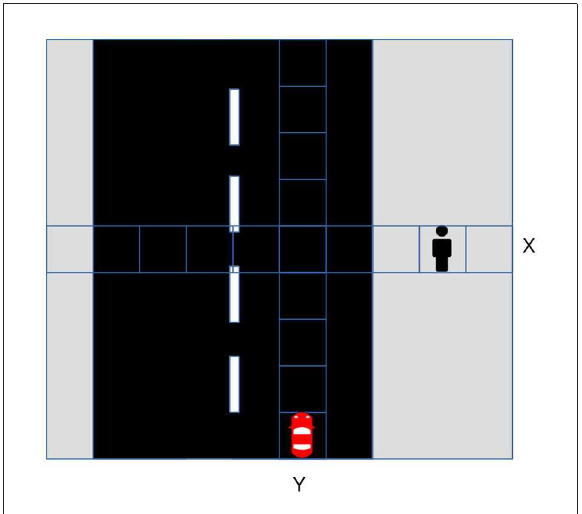
FIGURE3 Sequential Chicken model scenario: The pedestrian wants to cross the road, in the path of an oncoming AV. Space is quantised into squares, with each agent’s location measured as an integer distance from the collision square. In this example, the pedestrian’s X = 3 and the AV’s Y = 4. At each discrete time turn, both agents choose whether to move forwards at their full speed of two squares, or attempting to yield to the other by slowing to a single